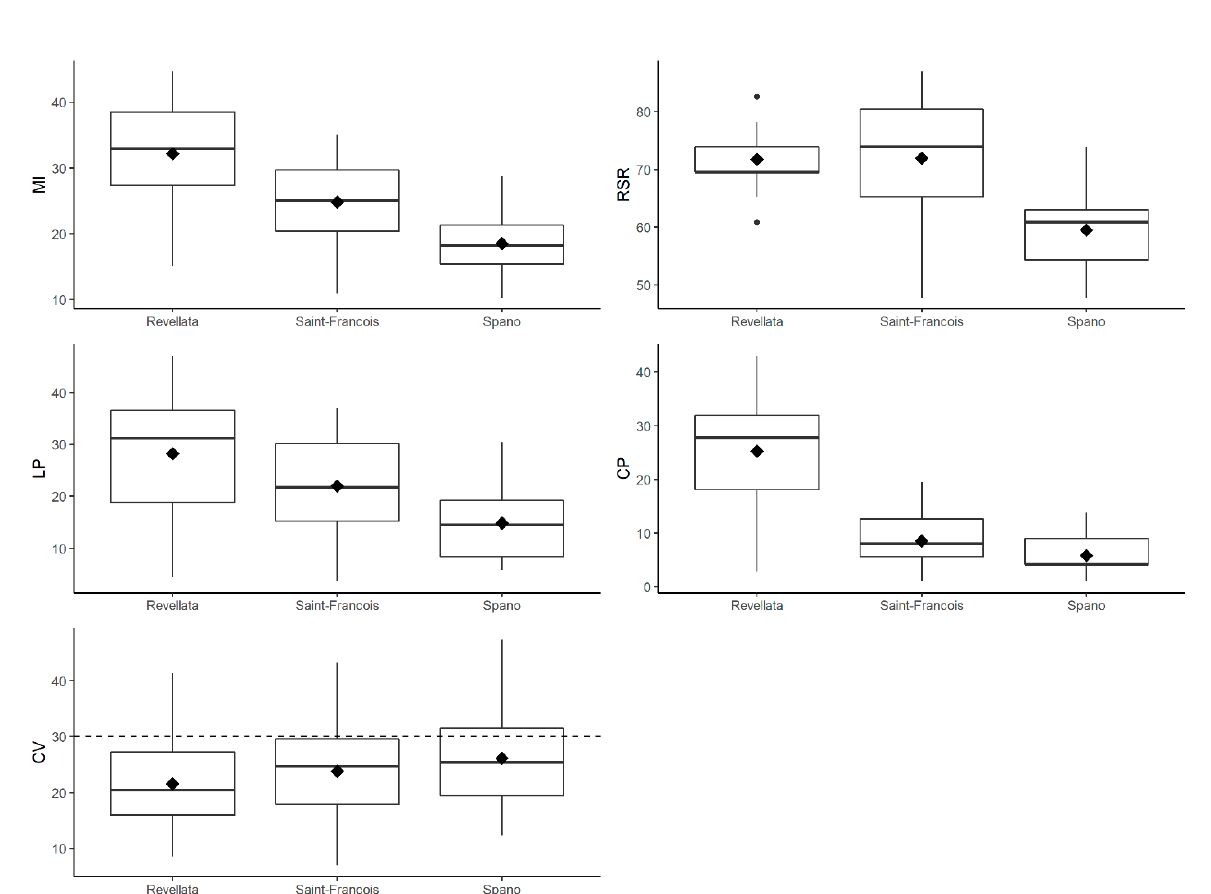
Figure 2. Spatial evolution of FAST results (CP, LP, MI, RSR) between 2012 and 2017 in the Saint-Francois, Spano, and Revellata zones.